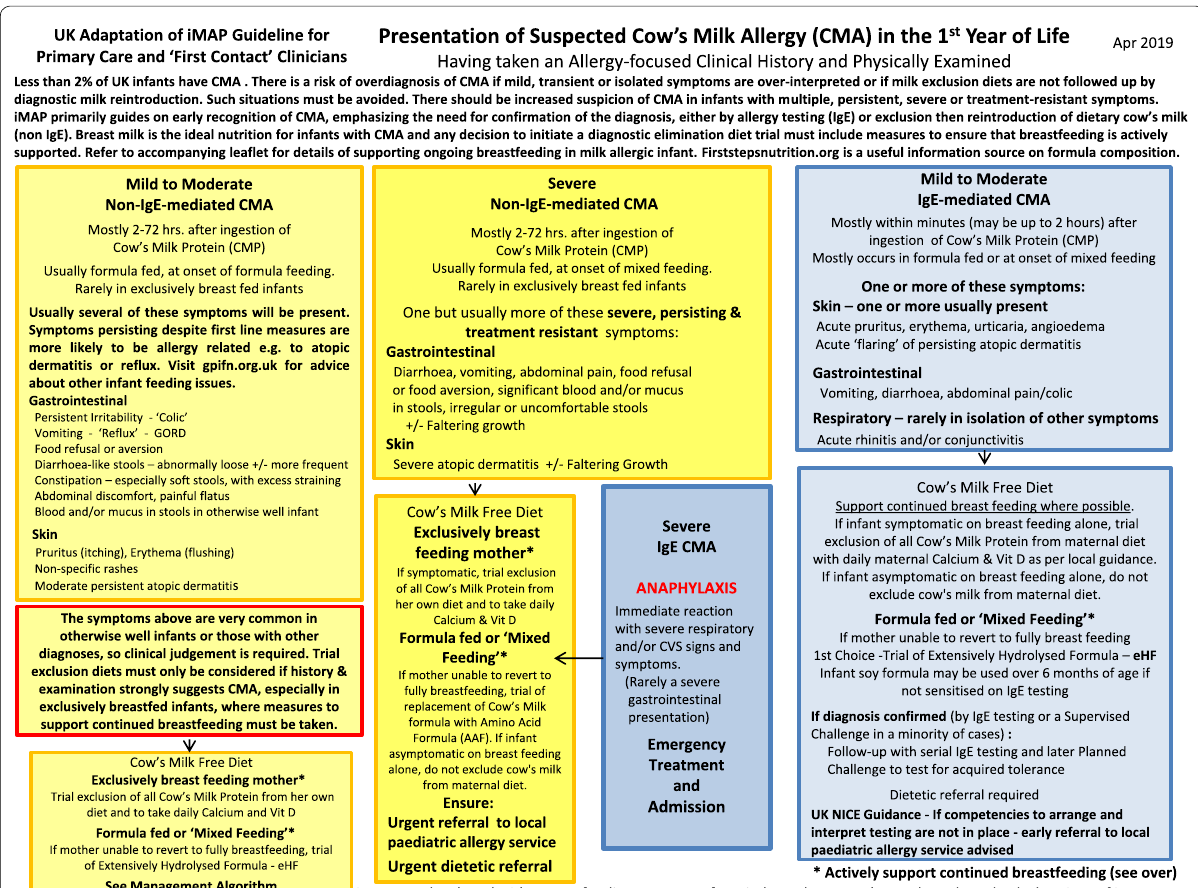
Fig. 1 Presentation of suspected cow’s milk allergy (CMA) in the 1st year of